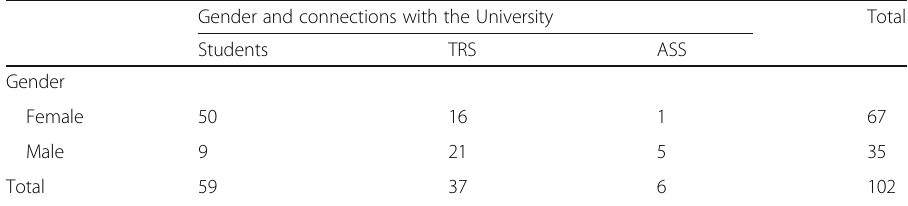
Table 1 Gender and connections with the University Gender and connections with the